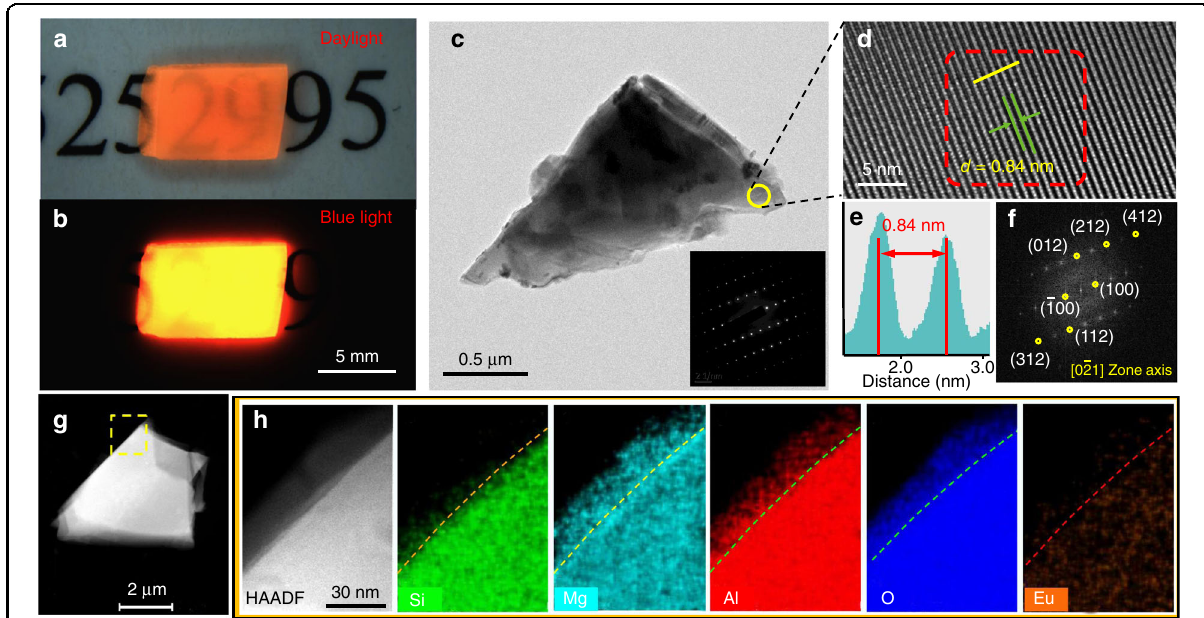
Fig. 2 Microstructure of the bulk Mg 2 Al 4 Si 5 O 18 :Eu 2 + red phosphor. Digital photographs the crystallized composite phosphor with a thickness of 0.4 mm taken under a daylight and b blue light. c Low magni fi cation TEM image of the phosphor particle, the inset is the corresponding selected area electron diffraction (SAED) pattern. d High-resolution TEM (HRTEM) pattern. e Corresponding intensity pro fi le of d across image marked by the dashed green box were obtained. f Corresponding FFT image. g , h HAADF-STEM image and the Energy dispersive X-ray (EDX) mapping of Si, Mg, Al, O, and Eu